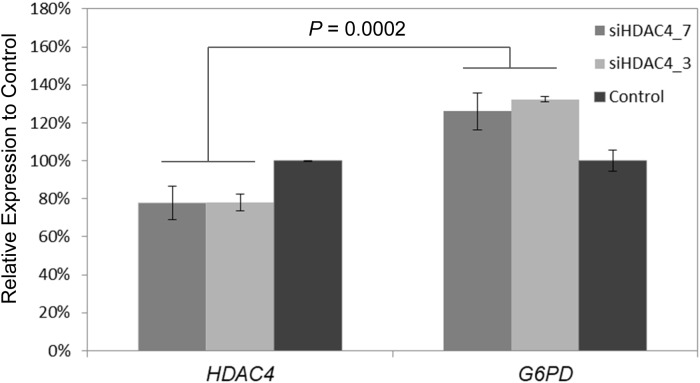
Knockdown of HDAC4 by RNA interference reveals upregulation of G6PD. Two siRNAs siHDAC4_7 and siHADC4_3 were designed to target HDAC4 and transfected into human HepG2 cells in vitro. Relative mRNA expression was measured by qPCR 48 h after transfection. Expression was normalized to ß-actin internal controls. Expression of G6PD was significantly increased relative to its expression in control cells and HDAC4 levels at 48 h post-transfection of siRNA. The data represent means ± SD (n = 3).